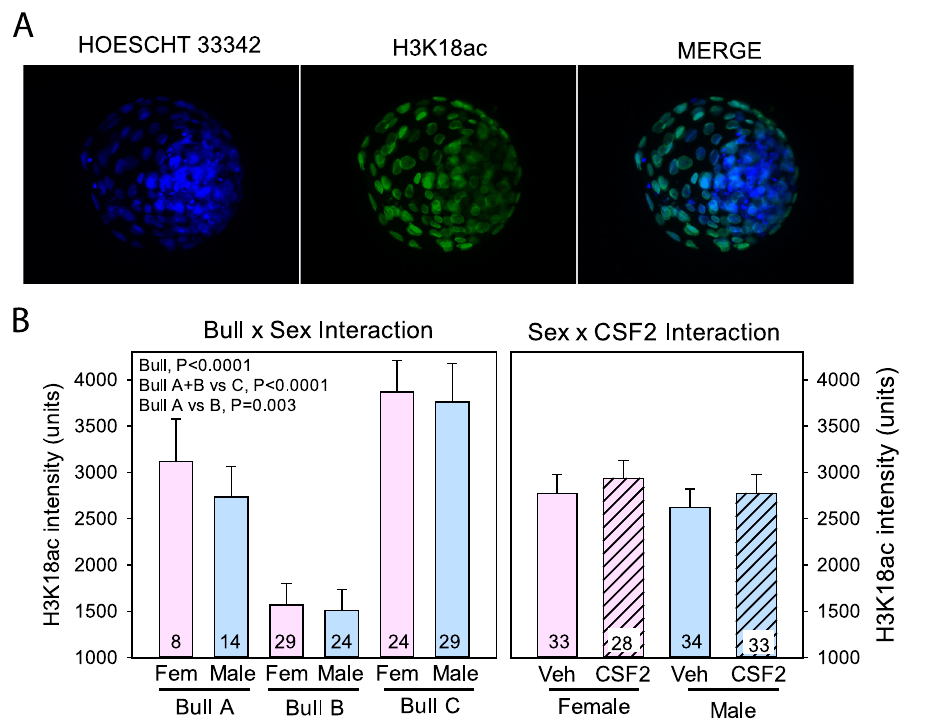
Fig 4. Immunolabeling for histone H3K18ac. A. Representative example of labeling of a blastocyst using antibody to H3K18ac. B. Least-squares means ± SEM of fluorescent intensity of H3K18ac in nuclei of TE cells as affected by sex, bull, and CSF2 and after using labeling for H3 as a